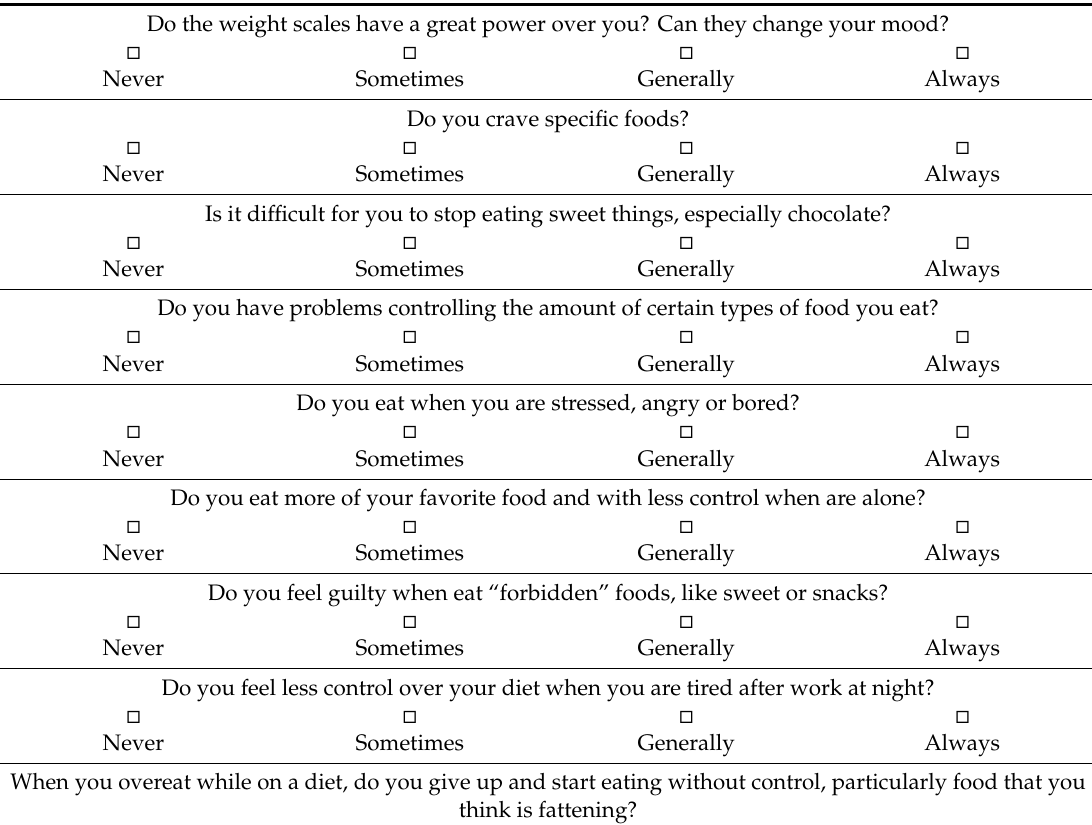
Table A2. Emotional Eater Questionnaire (EEQ)